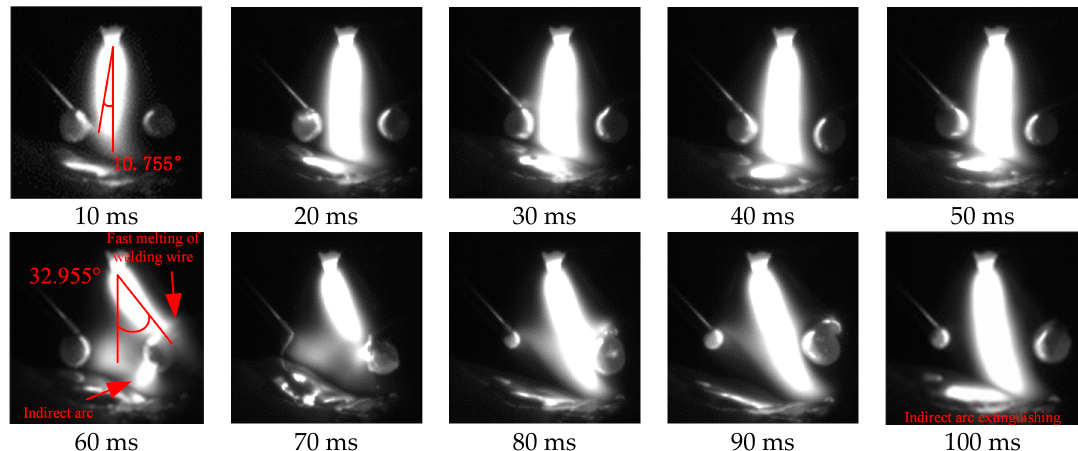
Figure 2. Arc swing in the model of “free transfer + free transfer.”